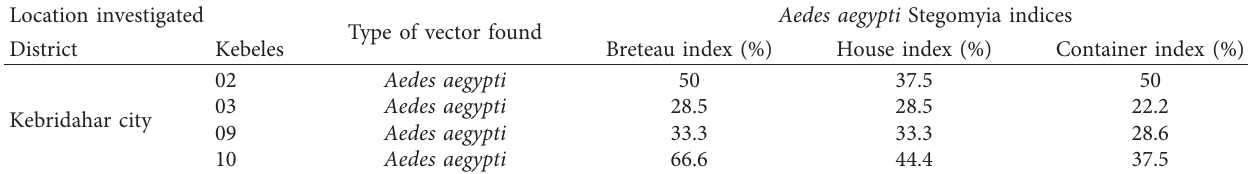
Table 4: Indices of Aedes aegypti mosquito by kebele in Kebridahar City Administration, Somali, Ethiopia, 2019. Location